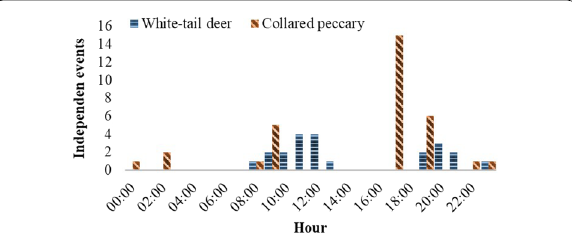
Fig. 7 Activity patterns of large herbivores in riparian